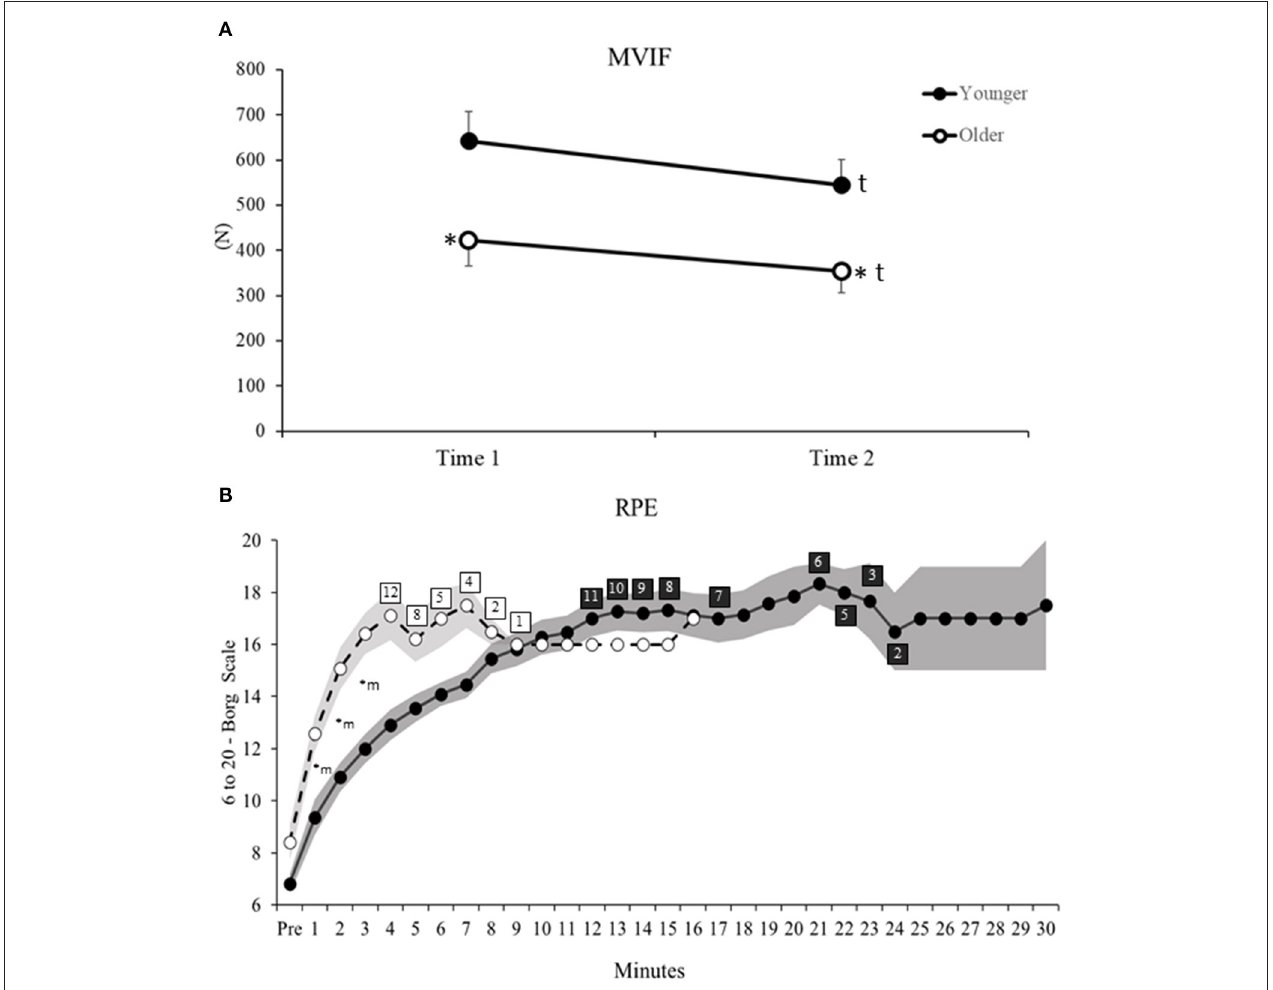
FIGURE 2 | (A) Maximum voluntary isometric force (MVIF) before (Time 1) and after (Time 2) rSTS. (B) Rate of perceived exertion (RPE) measured by 6–20 Borg scale during each minute of rSTS in younger (filled circles) and older adults (open circles). Shaded areas indicate standard deviation. Numbers on open and filled rectangles indicate the amount of older and younger participants who continued performing rSTS at that time. *Age differences, t Time main effect, m Minutes differences related to Pre (before